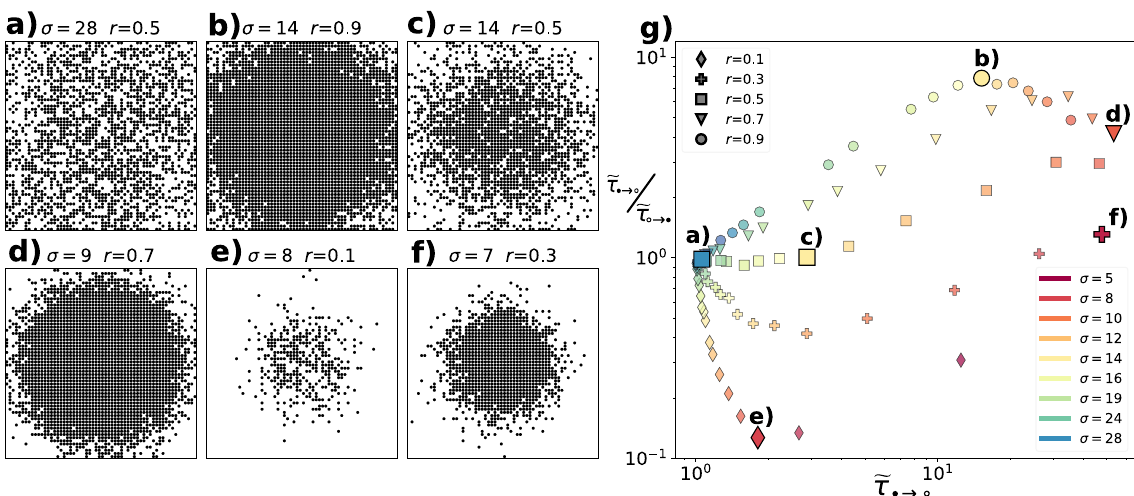
Fig. 4 Characterisation of colour distributions in 2D lattices. a – f Snapshots of the Gaussian cluster model for different values of the parameters σ and r in a regular 2D lattice with 60 × 60 nodes and two colours (cid:129) and ∘ . a σ = 28 and ratio = 0.5; b σ = 14 and ratio = 0.9; c σ = 14 and ratio = 0.5; d σ = 9 and ratio = 0.7; e σ = 8 and ratio = 0.1; f σ = 7 and ratio = 0.3. g Transition in the coordinates e τ (cid:3)!(cid:4) = e τ (cid:4)!(cid:3) as a function of e τ (cid:3)!(cid:4) for different values of σ (marker colour) and the ratio between colours (type of marker). Note that σ accounts for the dispersion of (cid:129) nodes, with higher values corresponding to a larger dispersion and low clustering.